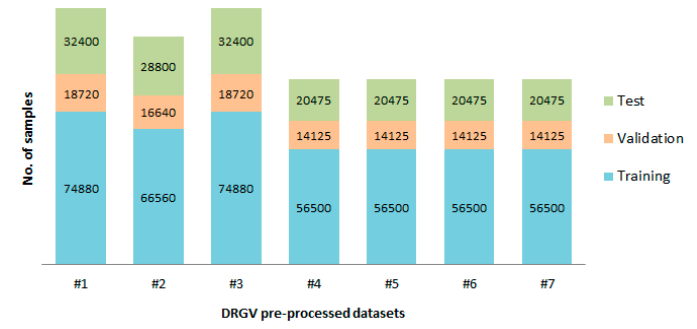
Figure 10. Data splitting from DRGV pre-processed datasets #1 to #7.